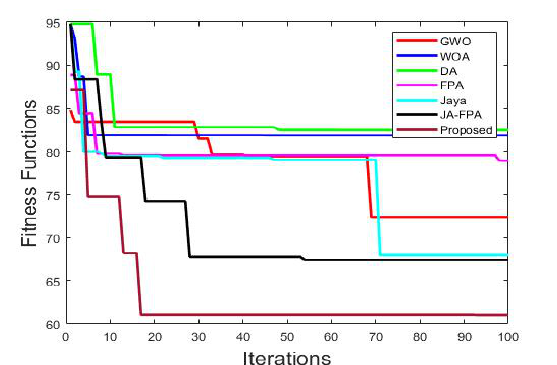
Figure 18. Comparative analysis of the fitness functions of our proposed system with an existing system